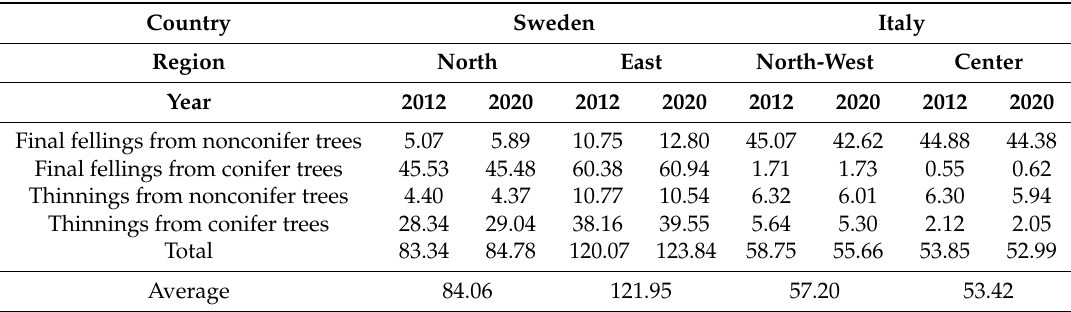
Table 4. Base potential of biomass in each region (t/km 2 )